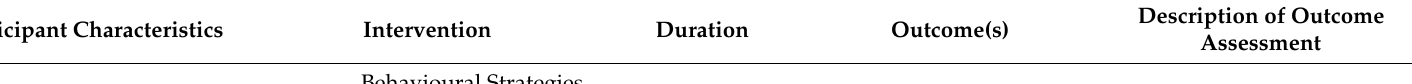
Table 2. Characteristics of included studies ( n =